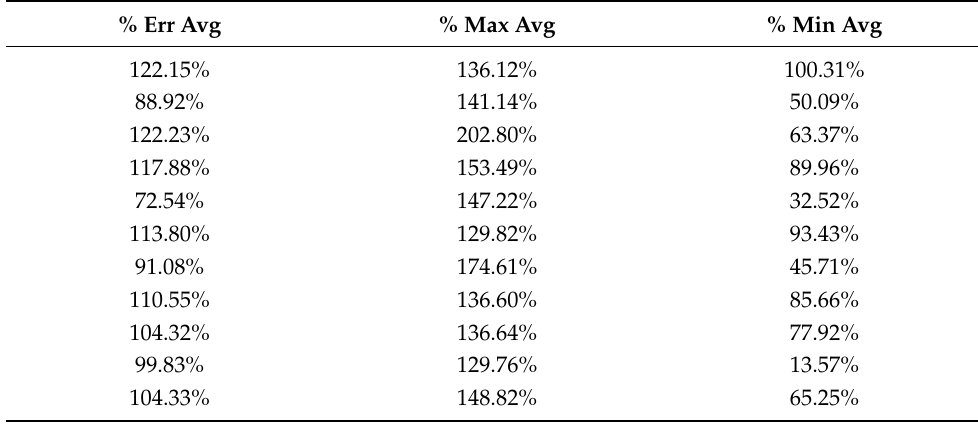
Table A183. Set 3, trials 11–20 data (average actual PR values).